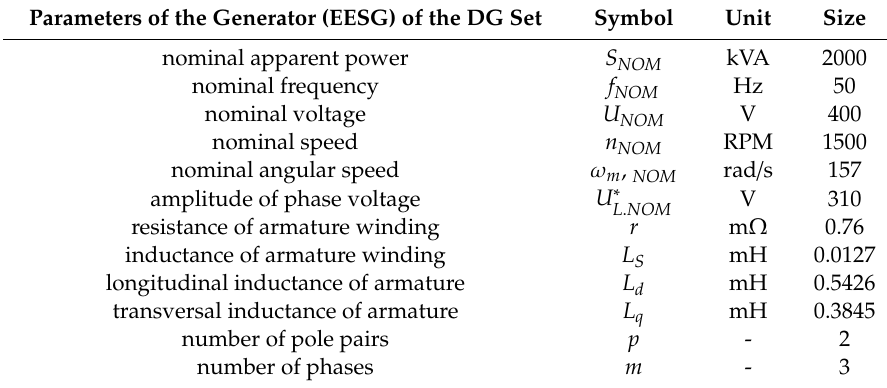
Table 2. Parameters of the EESG.